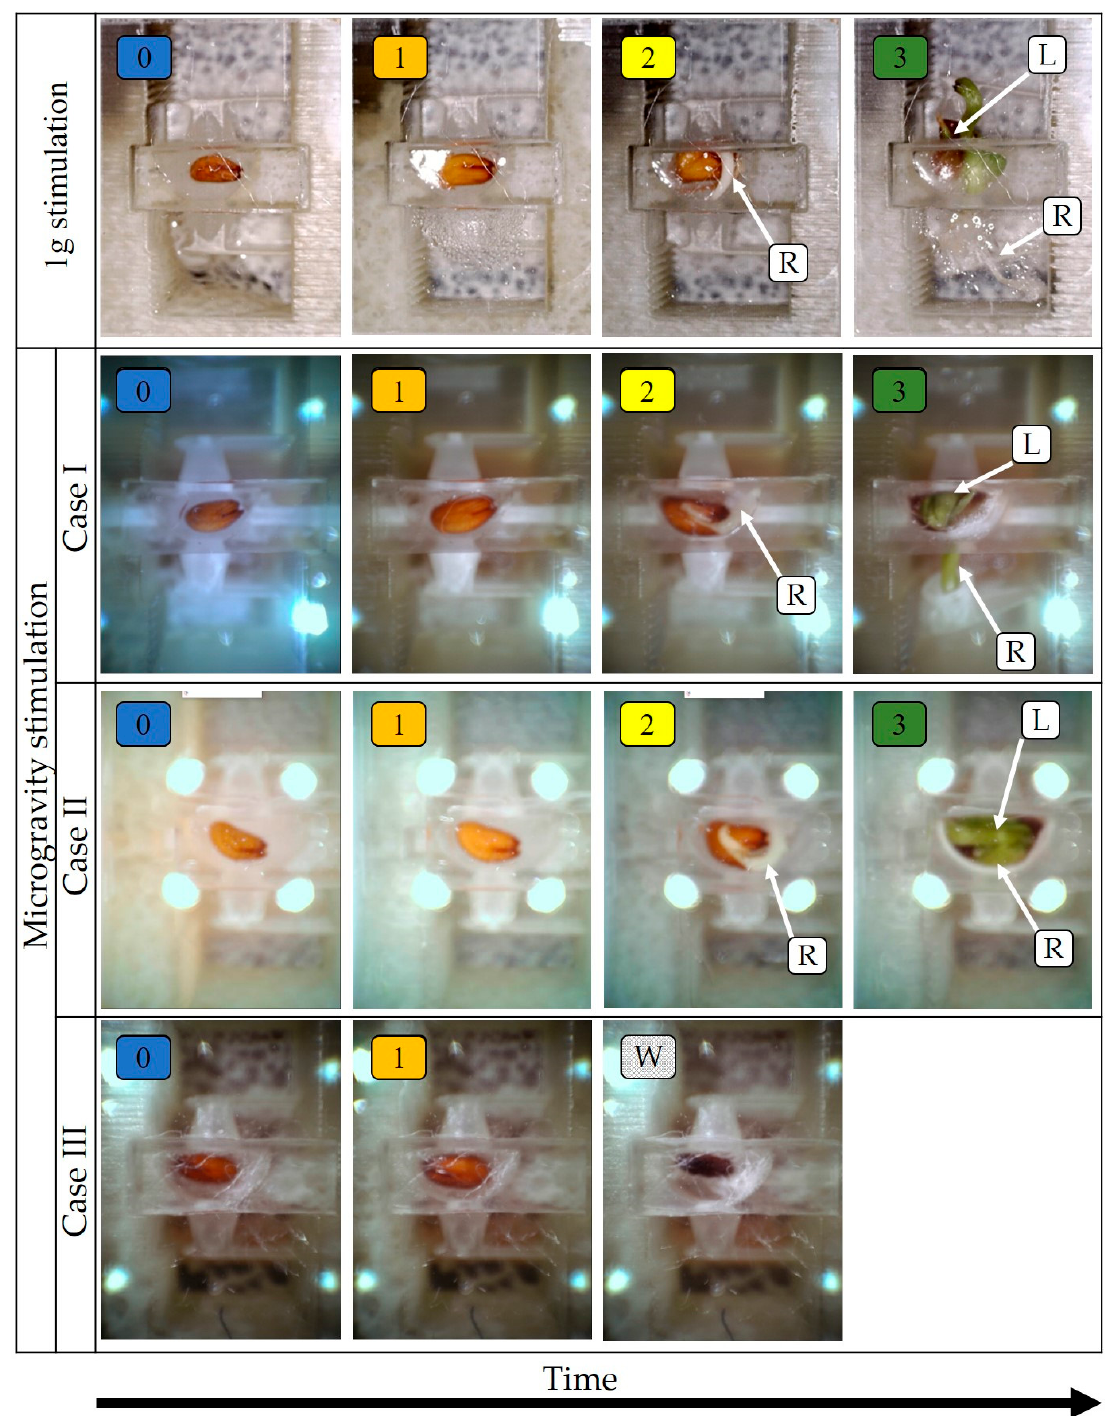
Figure 5. Seed growth stages during the experiment for exemplary grains: (0) beginning of the experiment (initial dry seed, start of water delivery); (1) grain swelling; (2) the appearance of the root; (3) the appearance of the leaf; and (W) seed wilt. The root (R) and leaf (L) are clearly visible at the end of the germination process.